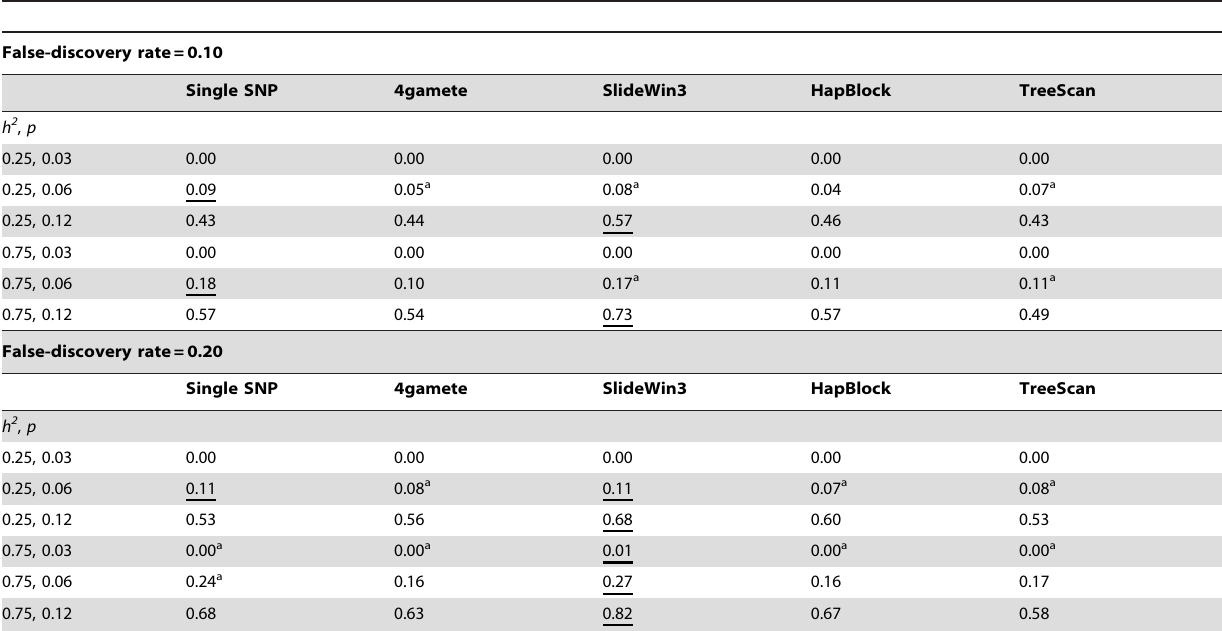
Table 3. Power of detecting single QTL removed from marker dataset for different heritability and QTL size levels and empirical false-discovery